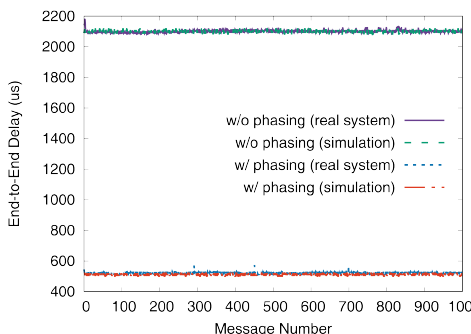
Figure 17. D e 2 e distribution of VC 0 in test set 1.